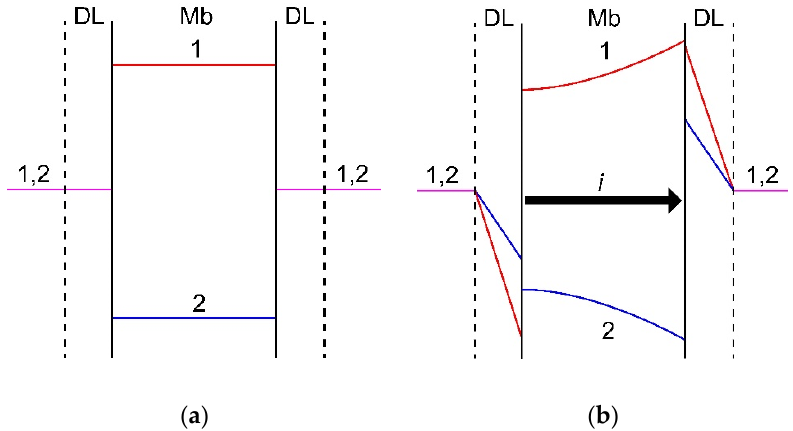
Figure 8. Scheme of concentration profiles in diffusion layers (DL) and a membrane (Mb) established at zero current ( a ) and a current density i close to 0.5 i lim ( b ). Counterion 1 is preferably sorbed by and transferred through the membrane as compared to counterion 2. The profiles match the results of calculation using model [330]. Explanations are given in the text.